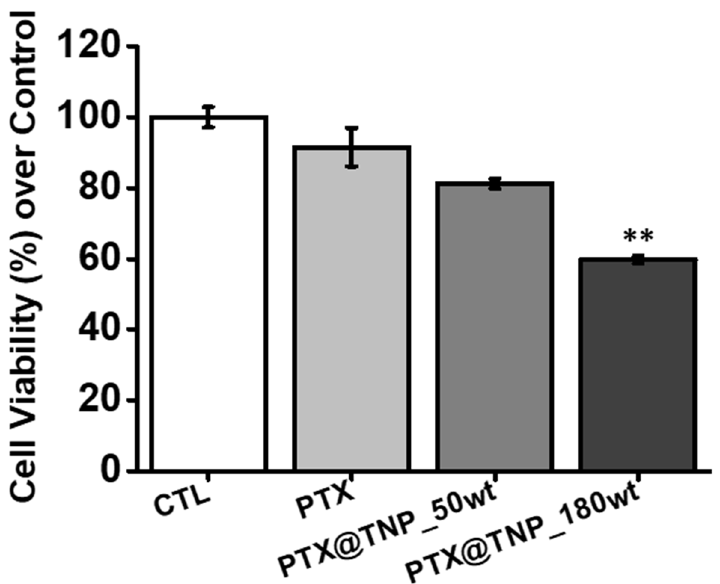
Figure 5. Anticancer efficacy of PTX@TNPs with different PTX loading amounts in the inhibition of cell proliferation in HCT 15 cells. Cells were incubated with free PTX or PTX@TNPs (50 wt% and 180 wt%) containing 0.1 µg/mL PTX for 48 h. The cell viability was analyzed using a cell counting kit − 8 (CCK − 8) assay, and it is presented as the mean ± SD of at least triplicate experiments. ** p < 0.01, comparison between the free drug and PTX@TNPs.